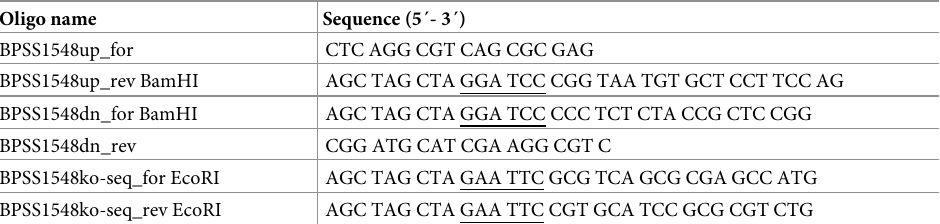
Table 1. Oligonucleotides used in this